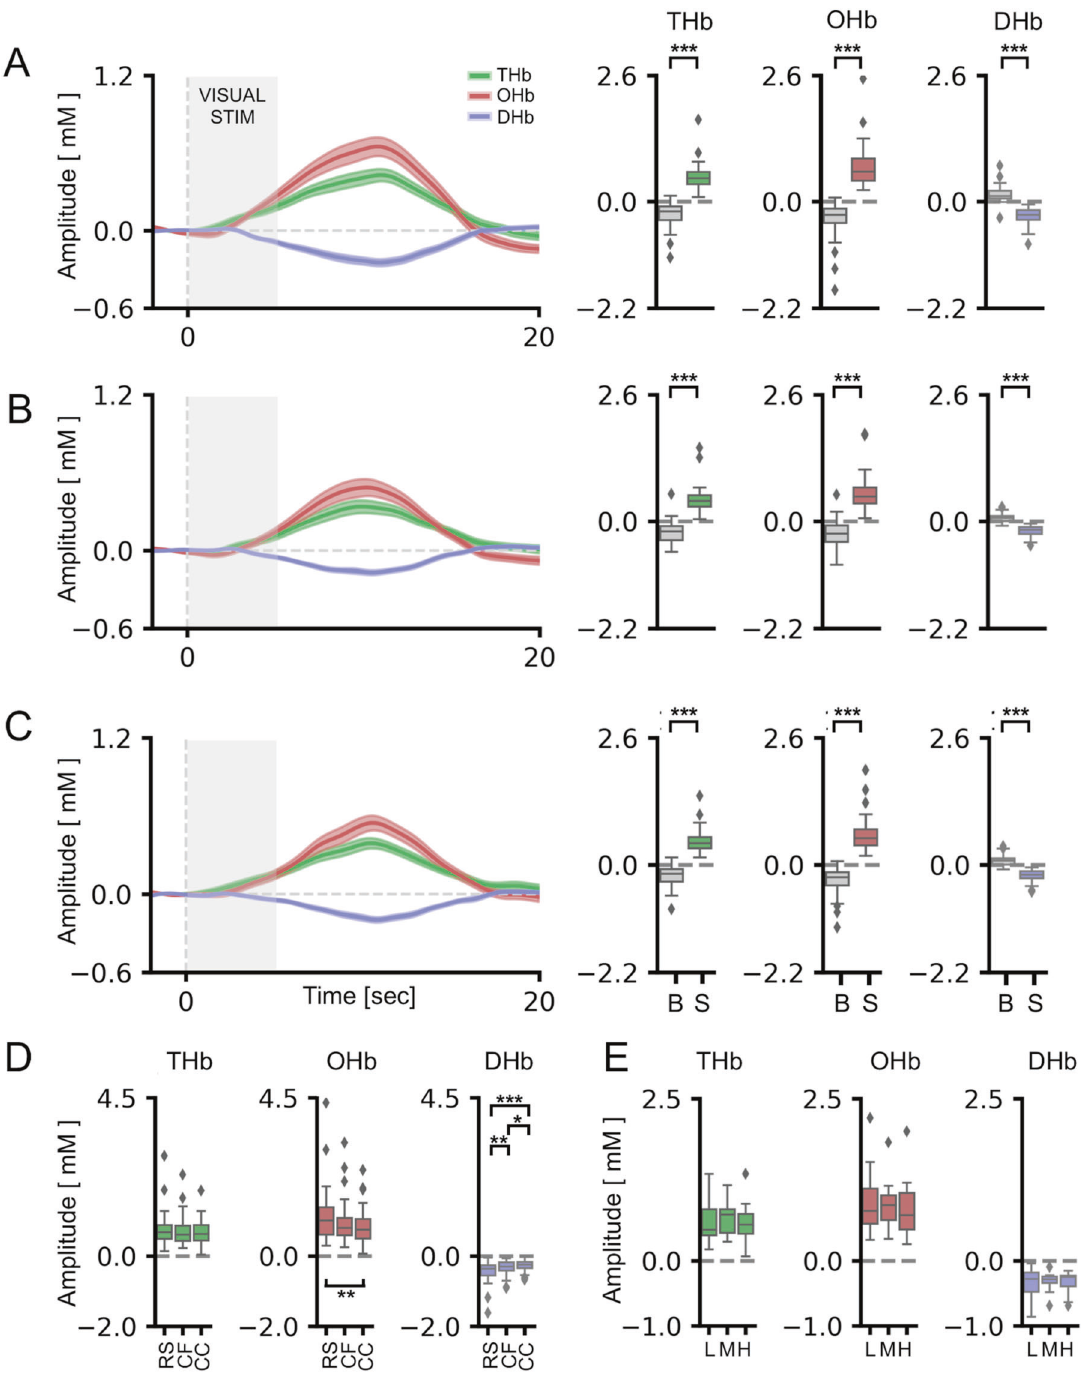
Fig. 2 HDR was reliably detected in adults using both RS and blended RS-animated cartoons. For all panels, values in the y -axis are multiplied for 10^4. A On the left, the average time course for THb (green line), OHb (red line), and DHb (blue line) in response to the Radial Simulus (RS) are shown. The three plots on the right depict the average peak response to the stimulus (S) vs. the blank (B) across all the adult subjects. The stimulus-driven signal was signi fi cantly different from the blank for all the conditions (t-test, p < 0.001 for all comparisons). B Same plots as above for the Cartoon Fixed (CF) condition. On the left, the average time course of the evoked HDR is depicted. On the right, the graphs showed that the HDR amplitude was signi fi cantly higher in response to S with respect to B for THb, OHb, and DHb (t-test, p < 0.001 for all comparisons). C Cartoon Chosen (CC) condition. Also in this case the S elicited signi fi cantly higher responses for THb, OHb, and DHb with respect to the B (t-test, p < 0.001 for all comparisons). D Comparison among different visual stimulations shows no differences in evoked amplitudes for THb, whereas a signi fi cant difference was detected between RS and CC for OHb (One-way RM ANOVA, p < 0.01, post hoc BH- FDR, RS vs. CC p < 0.01) and a more complex pattern of differences emerged for DHb (One-way RM ANOVA, p < 0.001, post hoc BH-FDR, RS vs. CF p < 0.01, RS vs. CC p < 0.001, CF vs CC p < 0.05). E No differences of evoked responses were detected with different contrast levels of the baseline movie (L: low, M: medium, H: high). For statistical metrics and details, refer to Table S1. Data are shown as average ± s.e.m. * p < 0.05; ** p < 0.01; *** p <